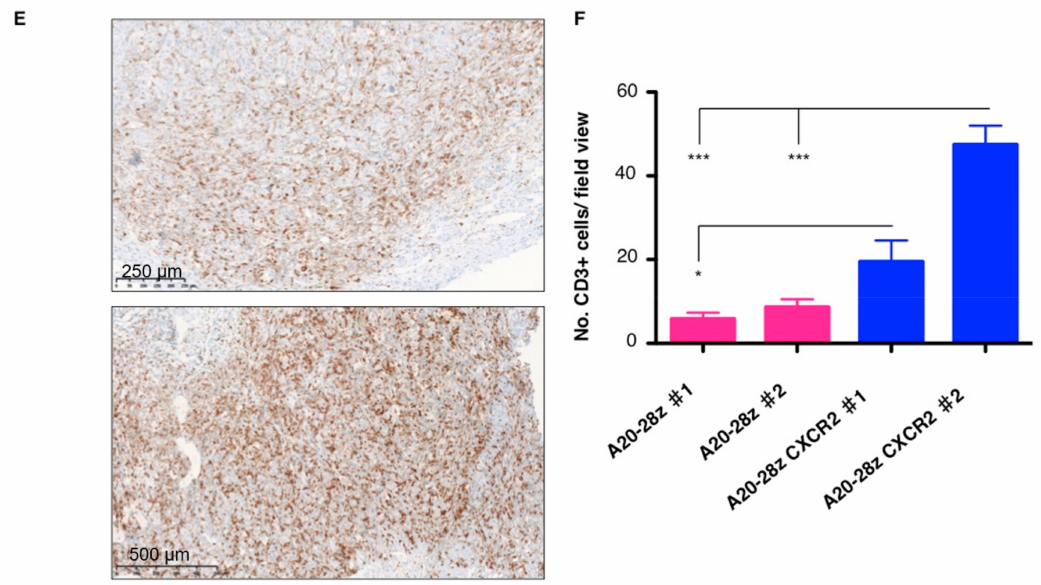
Figure 6. Improved e ffi cacy, tumor-homing and safety of A20-28z CXCR2 T-cells. ( A ) Mice were injected subcutaneously with 1 × 10 6 CFPac1-firefly luciferase cells and tumors were allowed to establish before treatment with a single dose of 5 × 10 6 CAR + T-cells, delivered IV on day 22. Control mice received PBS. Bioluminescence imaging using d-luciferin (substrate for ffl uc) was used to monitor tumor status. Data show the tumor-derived total flux of individual mice. ( B ) Weight of treated mice relative to pre-treatment weight (mean ± SEM; n = 3 mice per group). Tumors were harvested from mice treated with A20-28z ( C ) or A20-28z CXCR2 CAR T-cells ( D ) and stained for the presence of T-cells using an anti-human CD3 antibody. Higher magnification images of boxed regions in D are shown in ( E ). ( F ) Quantification of CD3 staining. Data shows the mean ± SEM number of CD3 + ve cells per field of vision from 13–20 high magnification ( × 40) fields of vision per tumor section shown in ( C ) and ( D